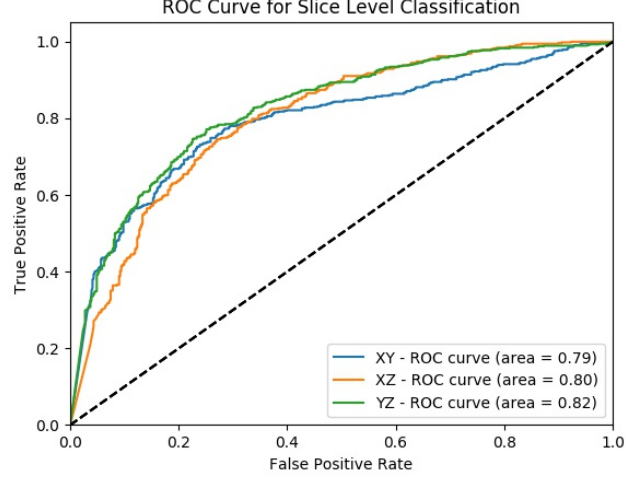
Figure 12. MPF model—ROC curves across different perspectives for slice-level classification.